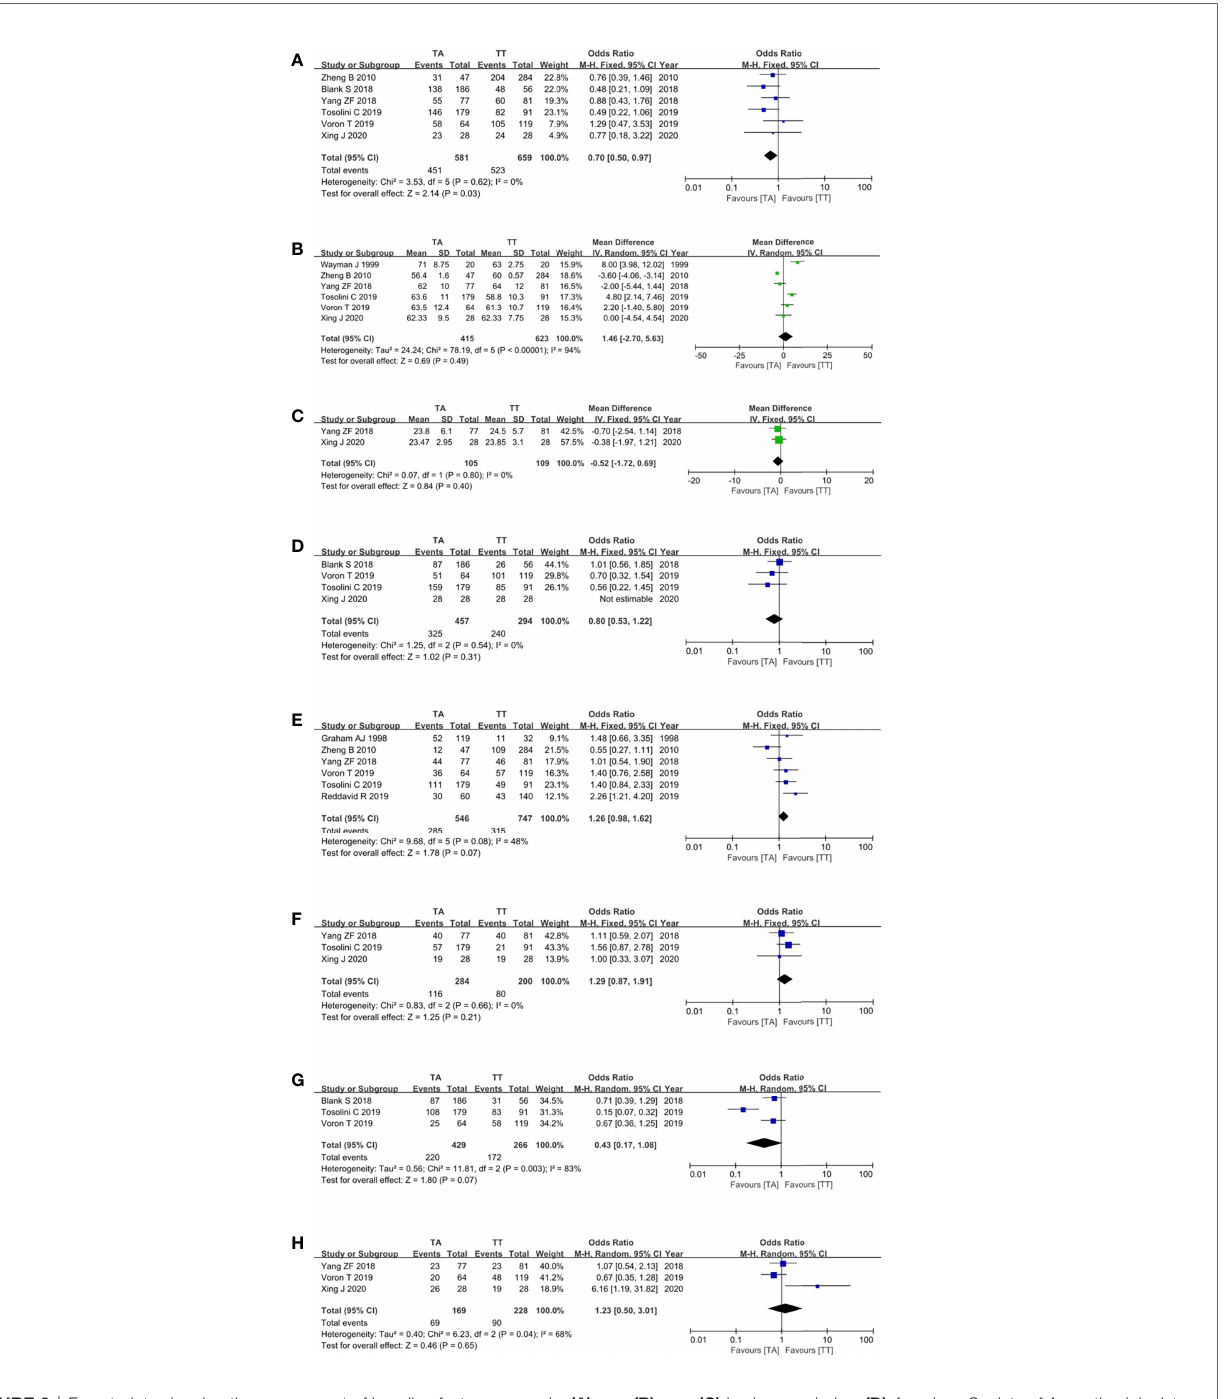
FIGURE 3 | Forest plots showing the assessment of baseline features, namely, (A) sex, (B) age, (C) body mass index, (D) American Society of Anaesthesiologists score, (E) pathological stage, (F) histologic type, (G) neoadjuvant chemoradiotherapy, and (H) postoperative chemoradiotherapy. TA, transabdominal, TT,